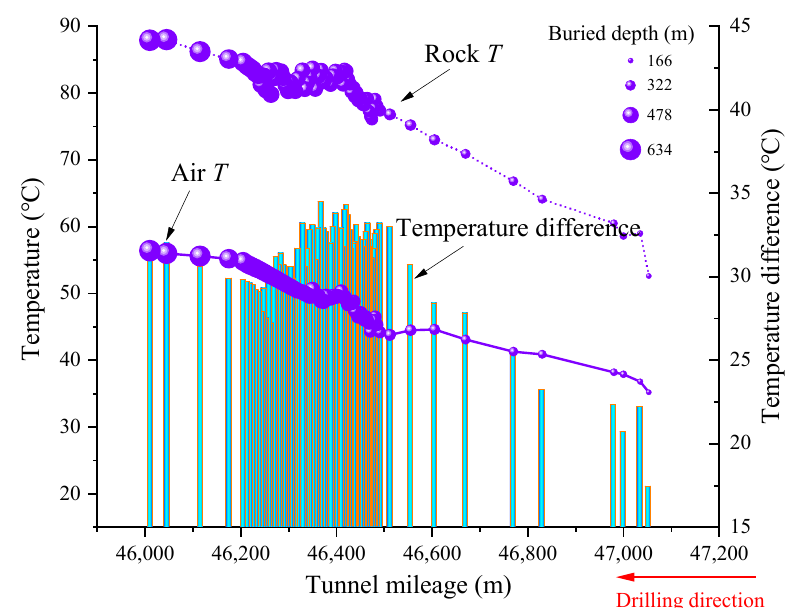
Figure 7. Variation curves of the rock temperature and the air temperature with the tunnel mileage and the buried depth, in which T is the abbreviation of temperature.